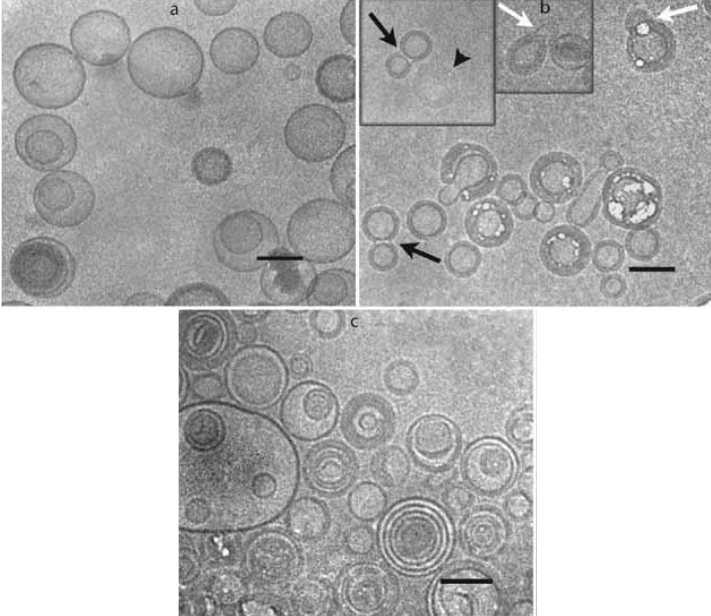
Figure 3. Cryo-transmission electron microphotographs of 1,2-distearoyl-sn-glycero-3-phosphocholine (DSPC)/cholesterol (60:40, mol/mol) liposomes prepared in water ( a ) and after addition of 10% ( w / v ) lactose to the external solution ( b ). The microphotograph shown in ( c ) was collected after freezing the liposome dispersion shown in (b). The black arrows denote peanut shapes structures, white arrows collapsed outer membrane of double liposomes and arrowhead in the inset of ( b ) denotes a completely collapsed liposome. Bars 1⁄4 100 nm. Reproduced with permission from [31], Elsevier Inc., 2010.